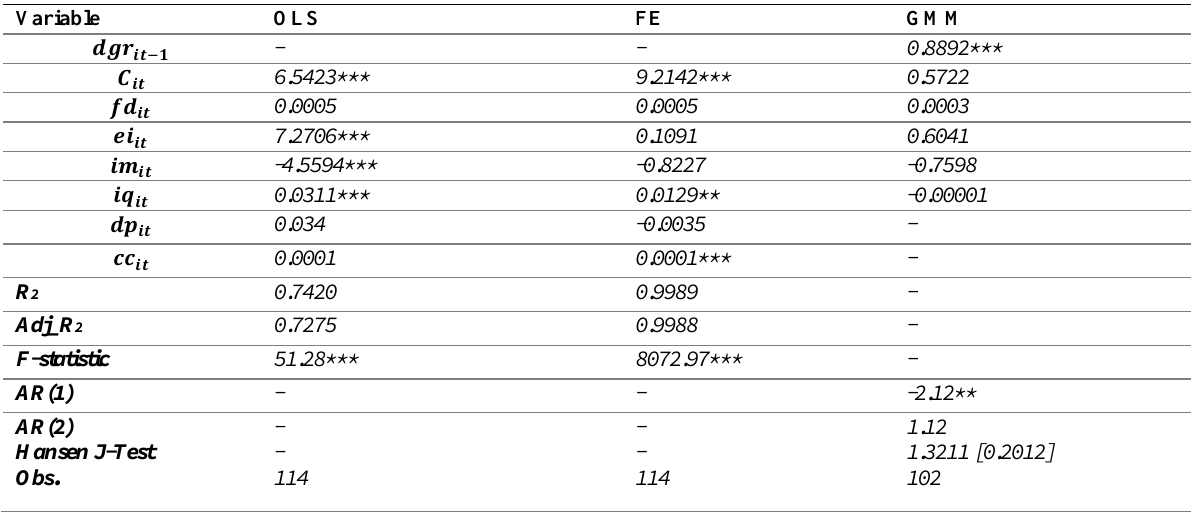
Table 4: Summary of Static and the Dynamic